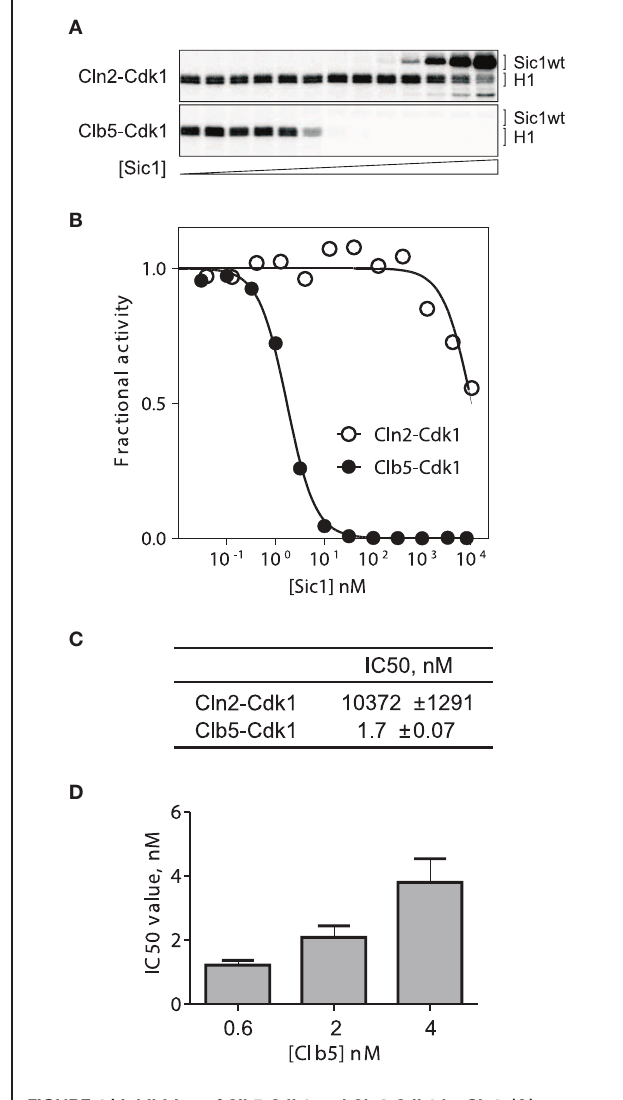
FIGURE 1 | Inhibition of Clb5-Cdk1 and Cln2-Cdk1 by Sic1. (A) Autoradiograph of a Clb5-Cdk1 and Cln2-Cdk1 inhibition assay. Sic1 is extensively phosphorylated by Cln2-Cdk1 whereas no detectable phosphorylation is seen with Clb5-Cdk1. (B) Inhibition curves for Clb5-Cdk1 and Cln2-Cdk1 are presented as the initial rates of histone H1 phosphorylation in the presence of different concentrations of Sic1. (C) Calculated IC50 values from the experiment in panel (A) . (D) The values of IC50 change in parallel with Clb5-Cdk1concentrations when both Sic1 and the kinase are varied in the picomolar or low nanomolar